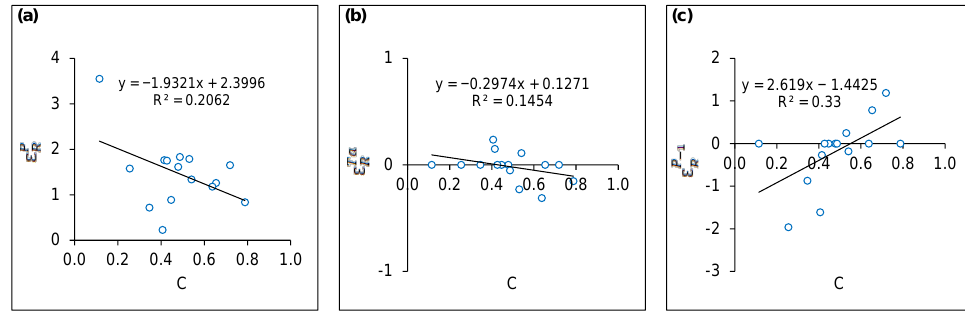
Figure 3. C versus ( a ) 𝜀 𝑅𝑃 , ( b ) 𝜀 𝑅𝑇𝑎 , and (c ) 𝜀 𝑅𝑃 −1 . Figure 3. C vs. ( a ) ε P